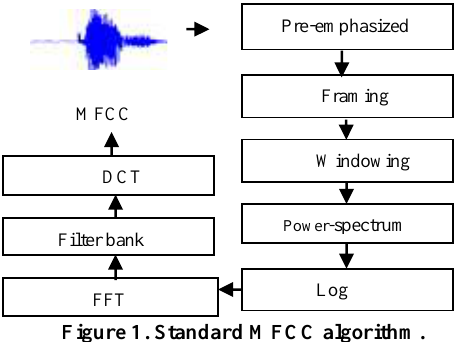
Figure 1. Standard MFCC algorithm.